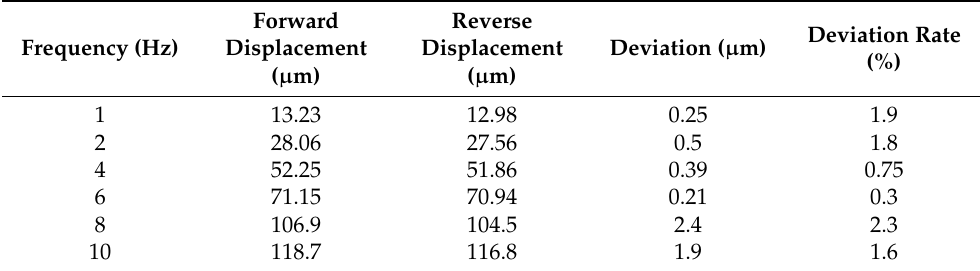
Figure 11. ( a ) The forward and reverse cumulative displacements of the improved actuator in 5 s, obtained under the fixed driving voltage of 100 V and various driving frequencies (1 to 10 Hz), and ( b ) the corresponding speed changing with the driving frequency. Table 4. The detailed forward and reverse accumulative displacements in 5 s obtained under various driving frequencies (1 to 10 Hz), as well as the deviation analysis.